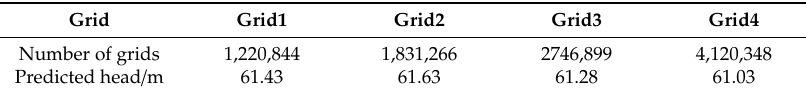
Table 2. Grid independence check for the simulation.